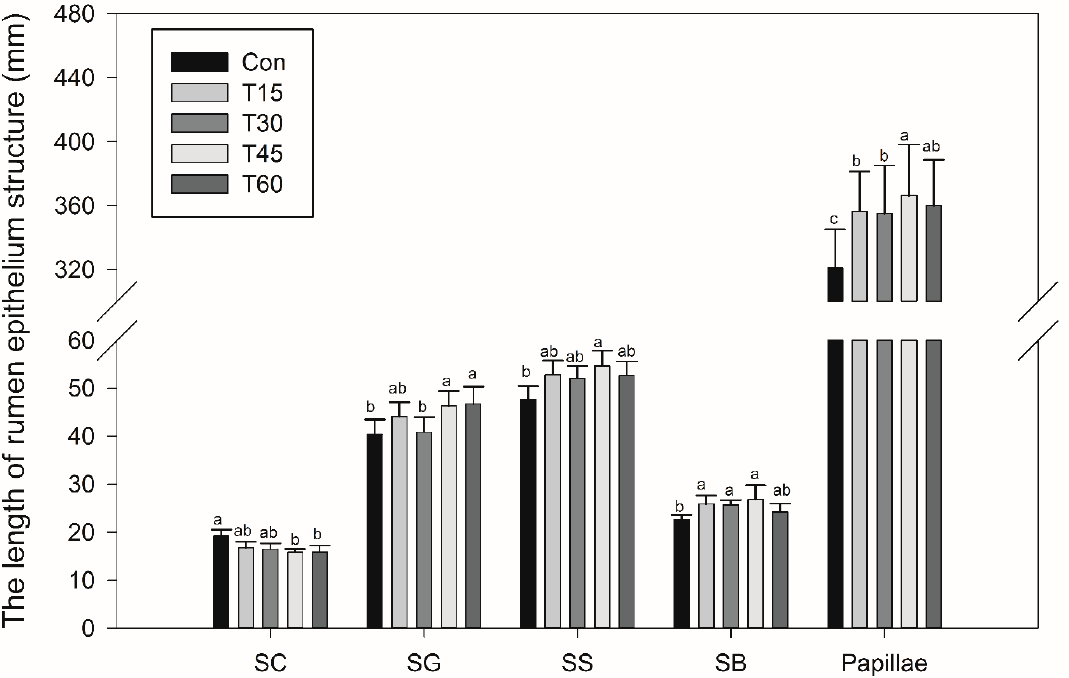
Figure 1. Morphometric variables of rumen epithelium structure in fattening Hu sheep fed with mulberry leaf powder. SC = Stratum corneum; SG = Stratum granulosum; SS = Stratum spinosum; SB = Stratum basale. a–c Bar chart within same epithelium structure with different superscripts differ significantly at p ≤ 0.05.